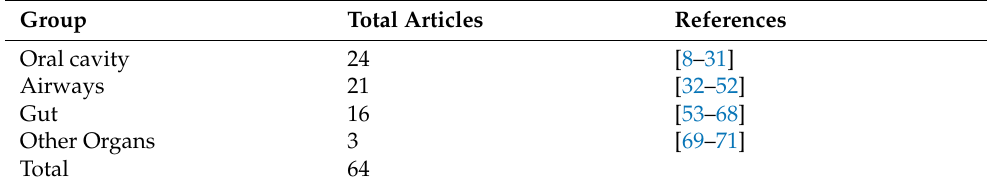
Table 2. List of the articles treated in the discussion divided in the four groups, and corresponding